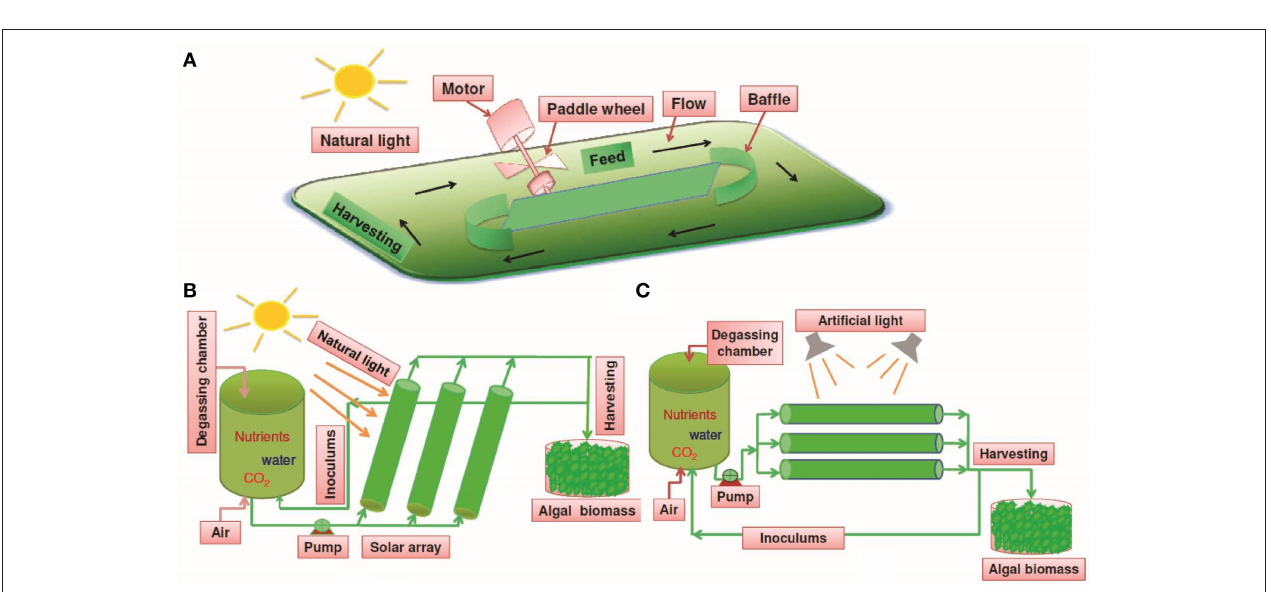
FIGURE 2 | Simplified outline for large-scale cultivation of microalgae. Photosynthetic microorganisms can be cultivated by providing nutrients, light, carbon dioxide, and water using different cultivation systems under controlled pH and temperature conditions. After mass cultivation, biomass is harvested for downstream processing.